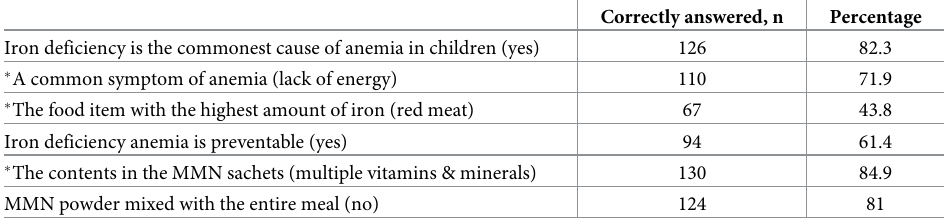
Table 3. Knowledge on anemia and MMN